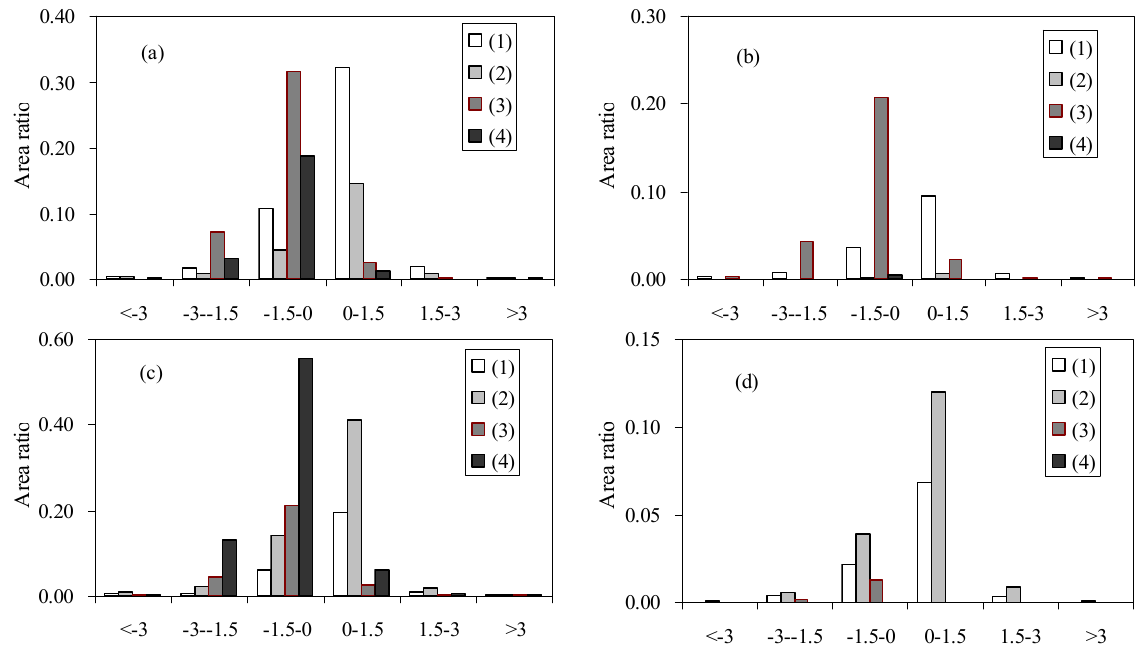
Figure 5. Statistical histogram of NPP dynamic index within the different scopes